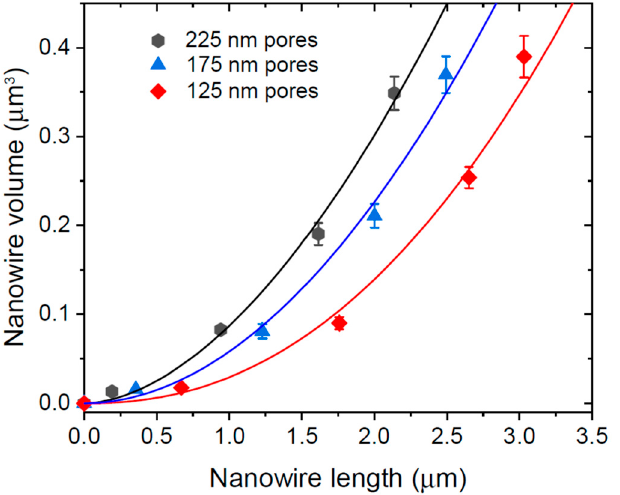
Figure 5. Volume of GaAs NWs grown by catalyst ‐ free SAE MOCVD at 750 °C in regular arrays of patterned pores in SiO 2 /GaAs versus the NW length for three different pore diameters shown in the legend (lines), fitted by Equation (20) with the parameters summarized in Table 4 (lines). Table 4. Parameters of radius ‐ dependent growth kinetics of SAE GaAs NWs . Pore Diameter (nm) Average initial NW Diameter (nm) 𝝀 𝟑𝒊𝒏𝒄 (nm) 𝝀 𝟑𝒅𝒆𝒔 /𝝀 𝟑𝒊𝒏𝒄 225 228 300 1.79 175 173 320 1.96 125 122 410 2.25